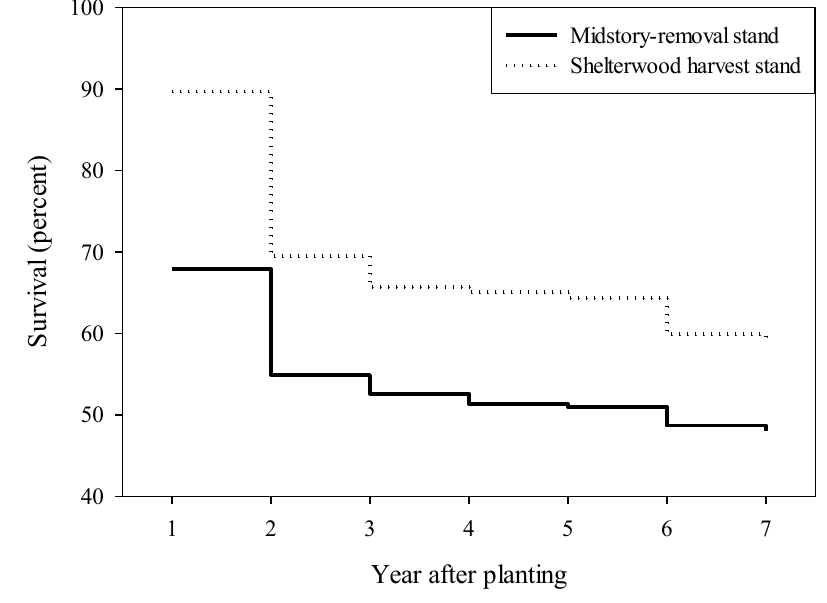
Figure 1. Survival of northern red oak seedlings in the midstory-removal and shelterwood harvest